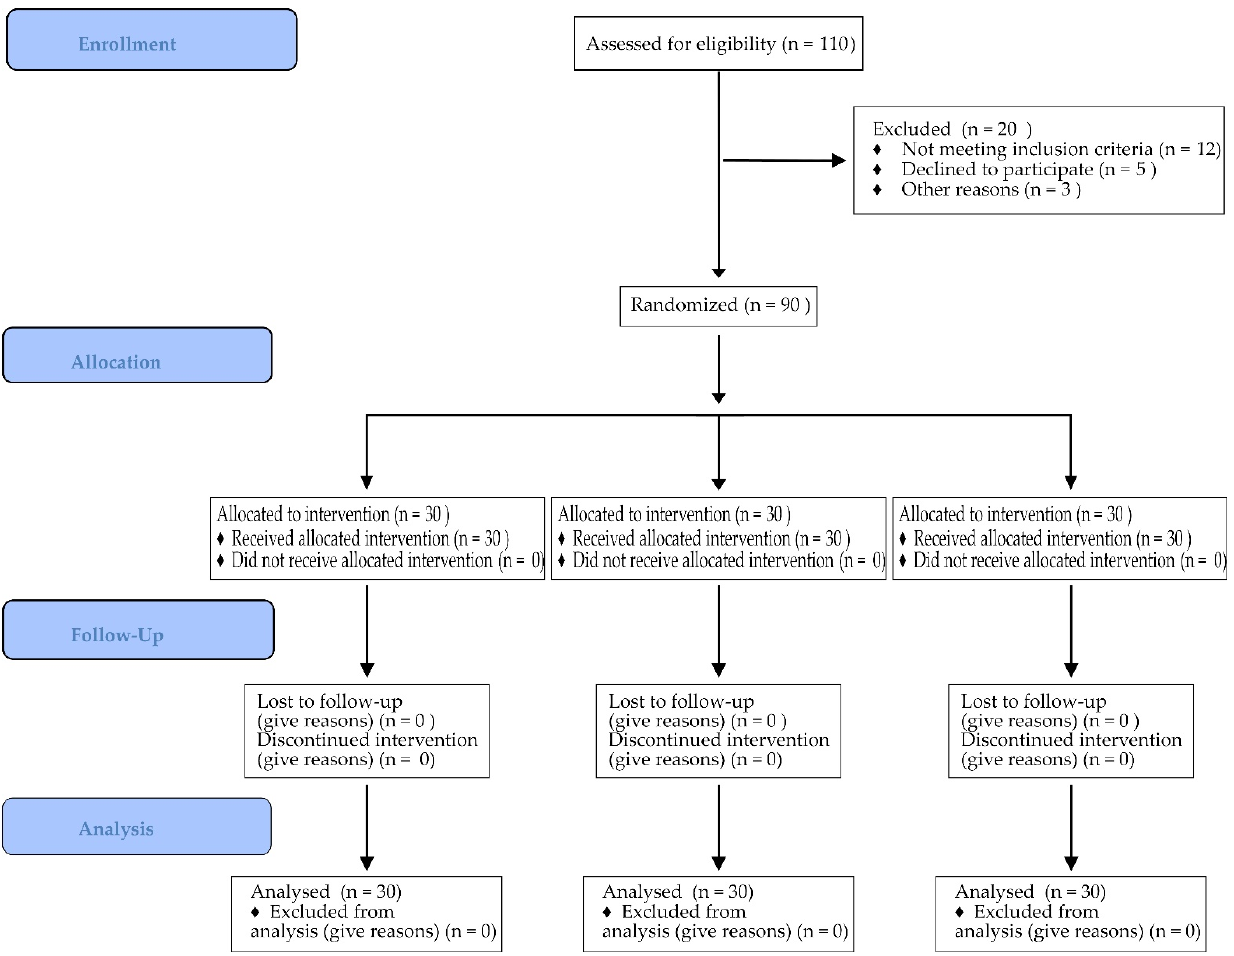
Figure 1 . CONSORT flowchart showing the study design and stages–Enrollment, Allocation, Follow-Up, and Analysis.